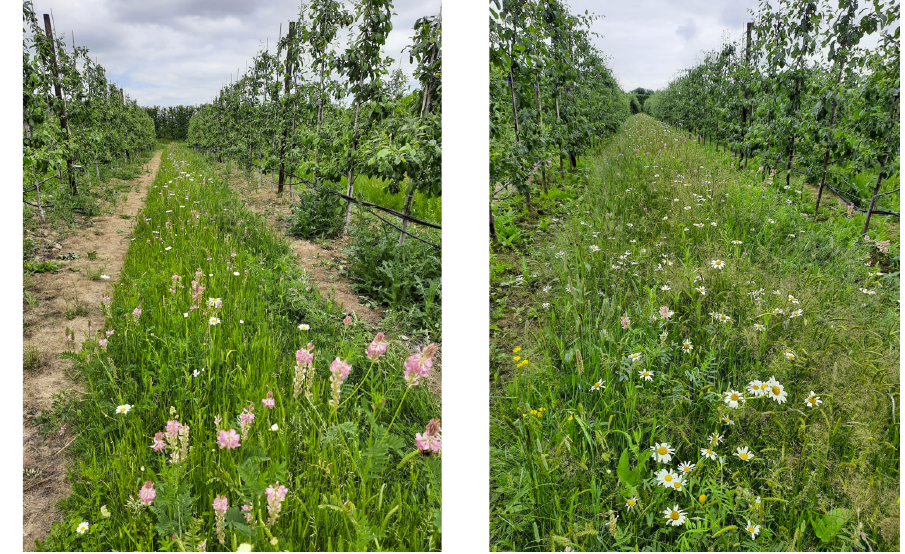
Figure 4. Orchard alleyway sowings with diverse flora and structure for natural enemies and polli ‐ nators (credit Celine Silva). pollinators (credit Celine